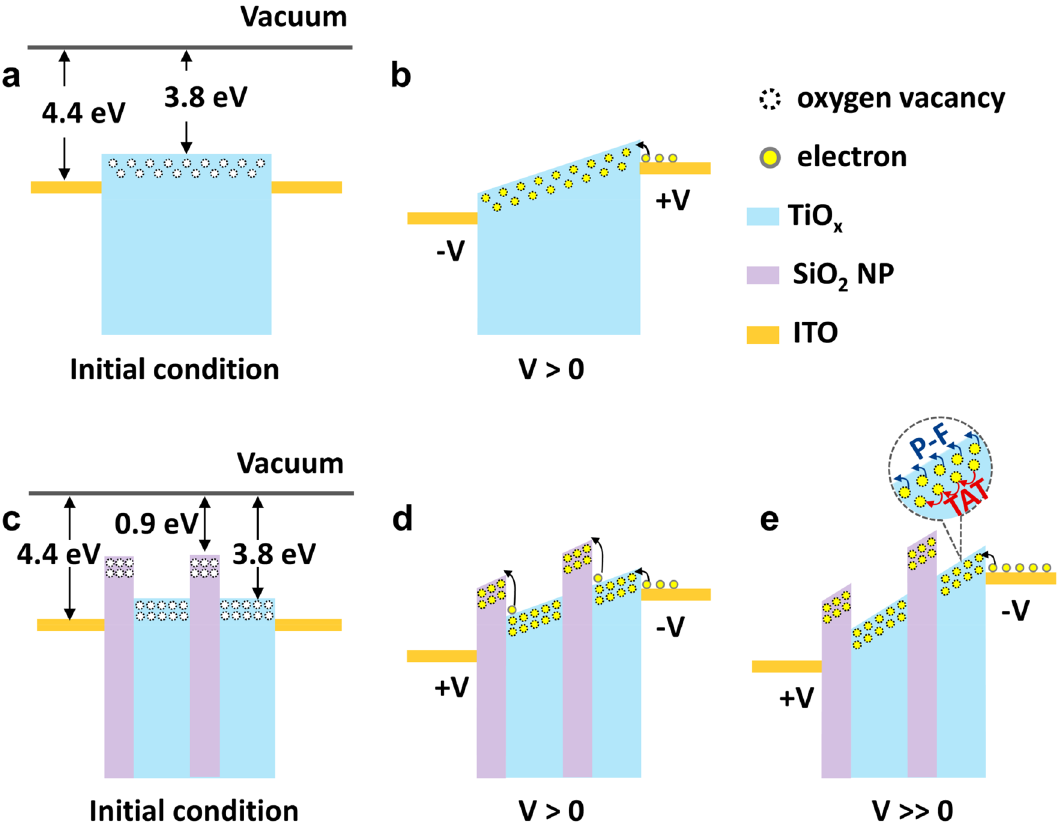
Figure 7. Schematic energy band diagrams for ( a,b ) the TiO x device and ( c – e ) the TiO x @SiO 2 NPs under initial states and SET